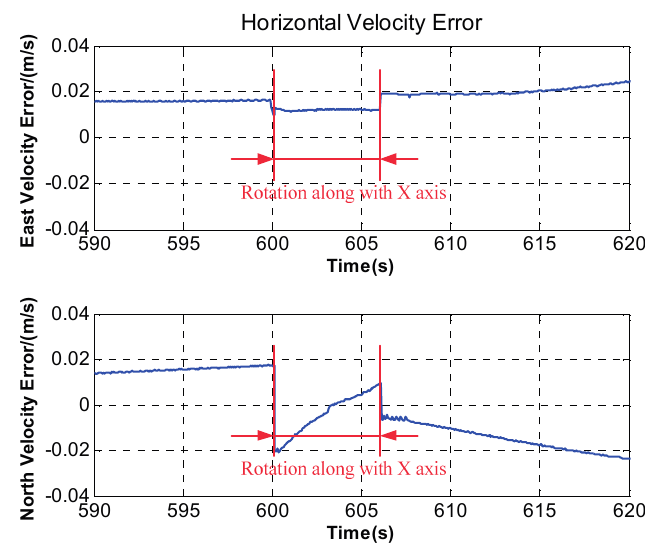
Figure 7. The horizontal velocity error.